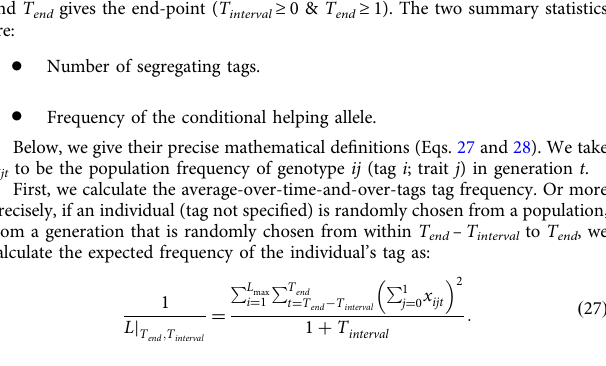
Fig. 4 for the exact relationship between tag frequency and coef fi cients of relat- edness). This means that, for increased tag availability ( L max ), kin